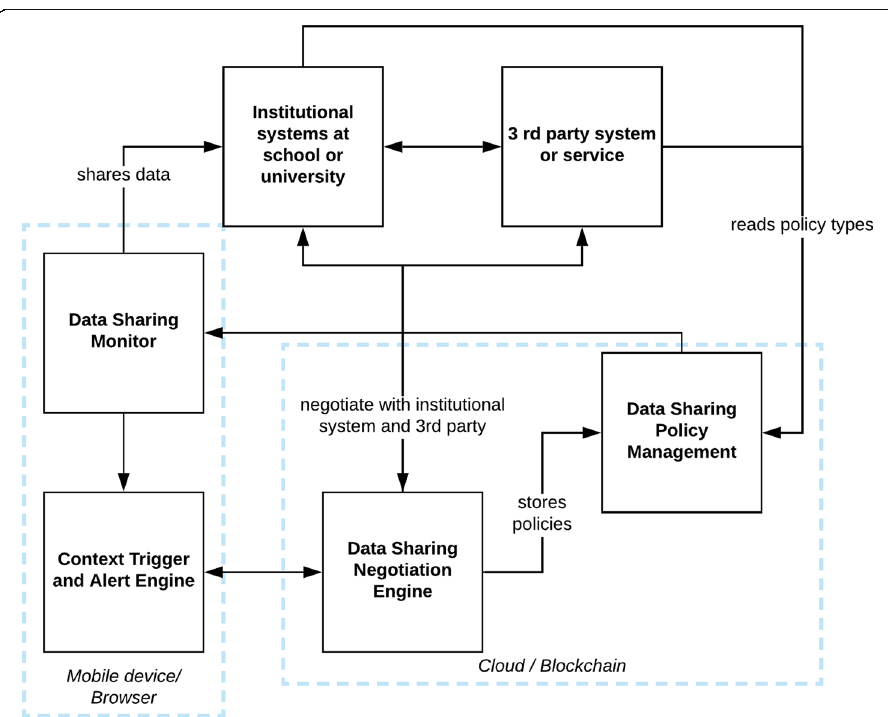
Fig. 10 Overview of proposed data sharing policy management